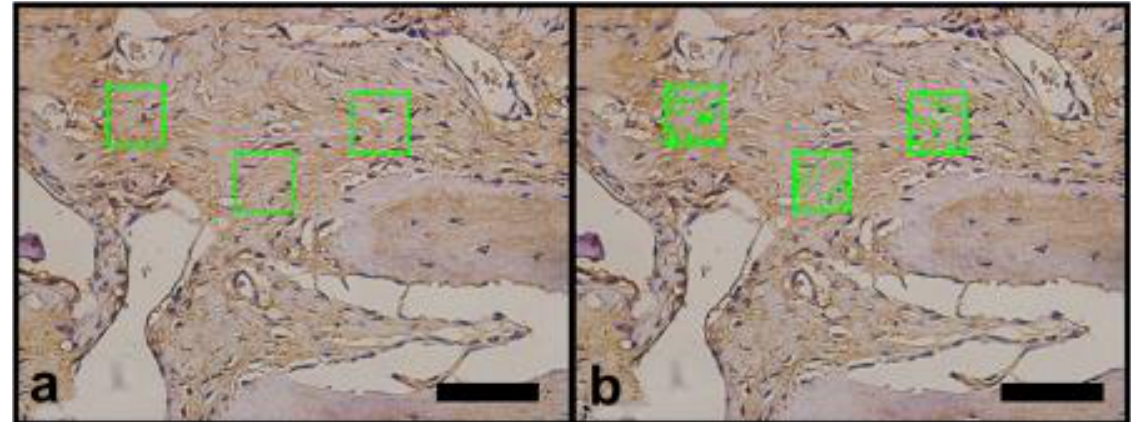
Figure 5. Photomicrographs of immunohistochemistry for osteopontin, quantification of the area of interest of the im- munostained slides for OPN (×40 magnification) (100 µm scale bar). ( a ) Green square areas limited the quantification sites randomly selected. ( b ) Green dotted area inside green square indicates the Image Pro Plus 7.0 software identification of the brownish color of the DAB deposits.